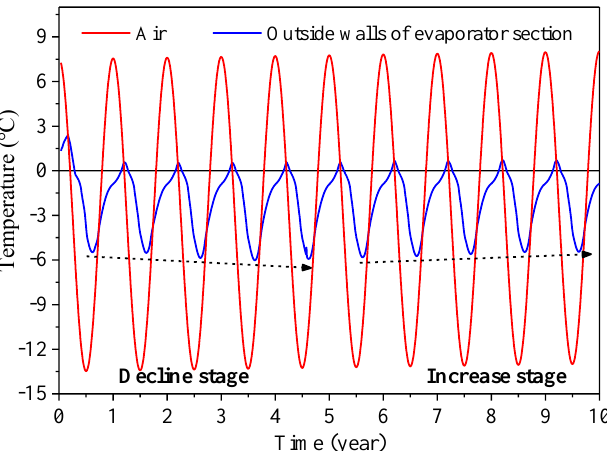
Figure 5. Variations in the average temperatures at the outer walls of the evaporator sections of L-shaped TPCTs with time (α = 50°).